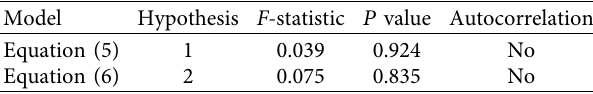
Table 4: The results of autocorrelation the error terms.